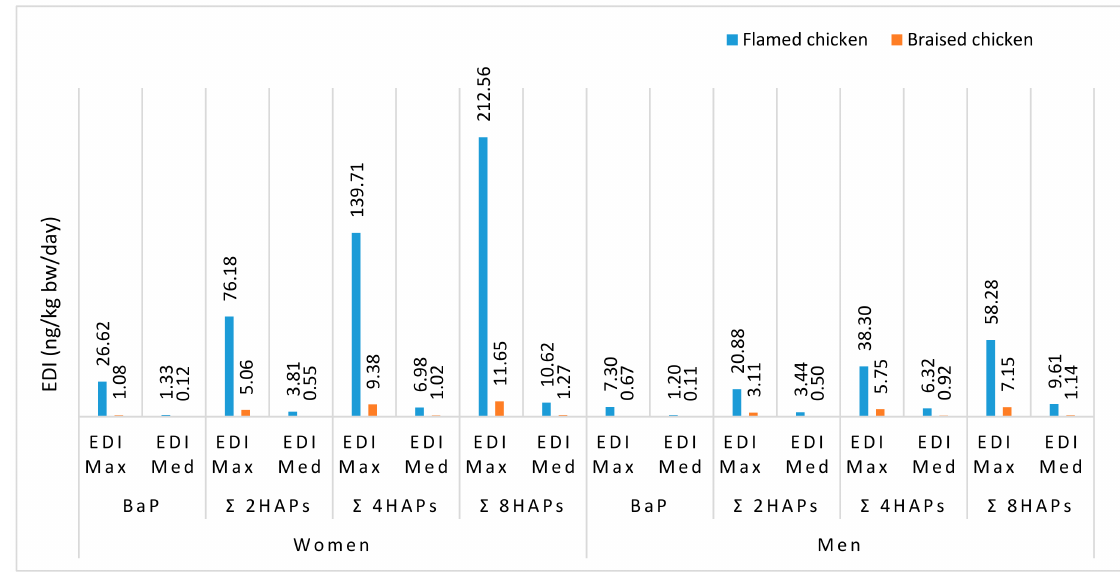
Figure 1. Daily intake of genotoxic PAHs (ng/kg